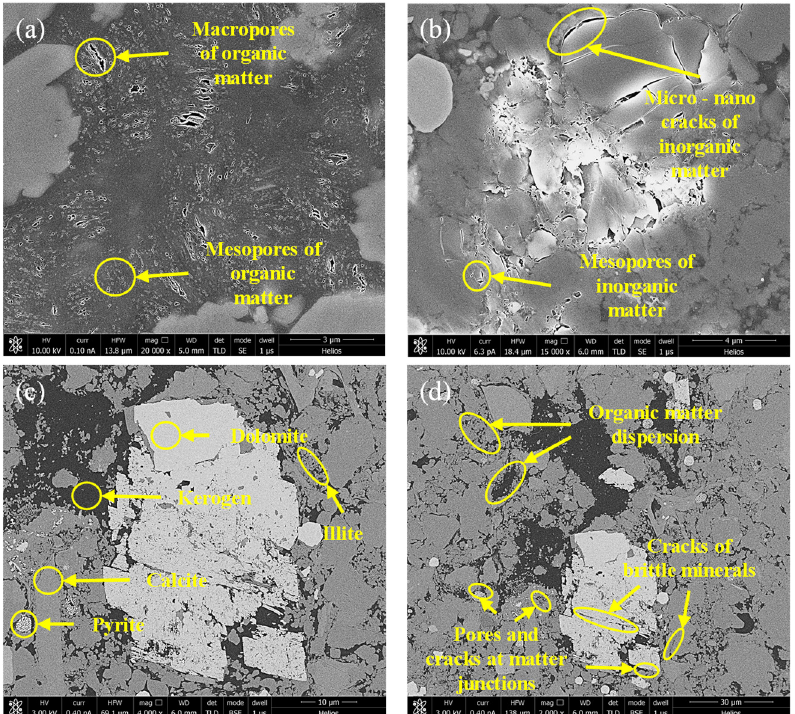
Figure 1. Pore and fracture structure characteristics of marine shale. ( a ) Organic matter contains many pores with poor connectivity. Most organic pores are micropores and mesopores with a di- ameter of less than 50 nm, and the number of macropores is relatively small. ( b ) The connectivity of inorganic pores is better than organic pores, most of which are macropores, and there are some micro–nano cracks. ( c ) The matrix of marine shale is mostly clay minerals and brittle minerals. In addition to a certain amount of organic matter, pyrite is scattered. ( d ) Organic matter wrapped by clay minerals is scattered in shale, and micro–nano cracks connect the pores in brittle minerals. In addition, there are many pores and cracks in mineral